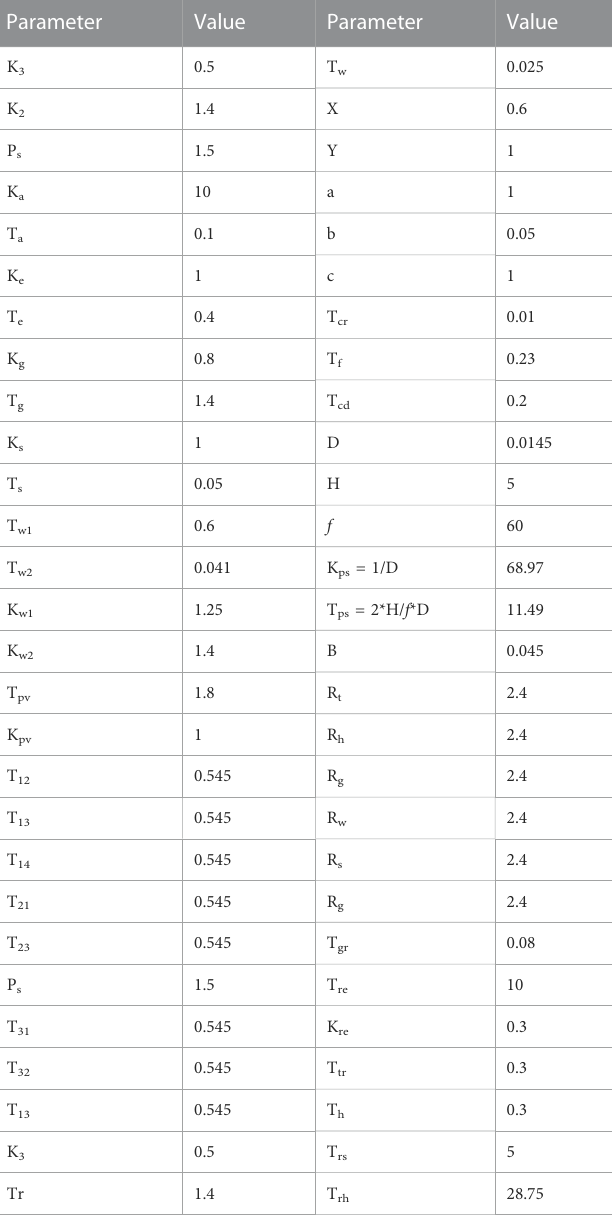
TABLE A1 Parameters of multi source hybrid power system (Liu et al.,